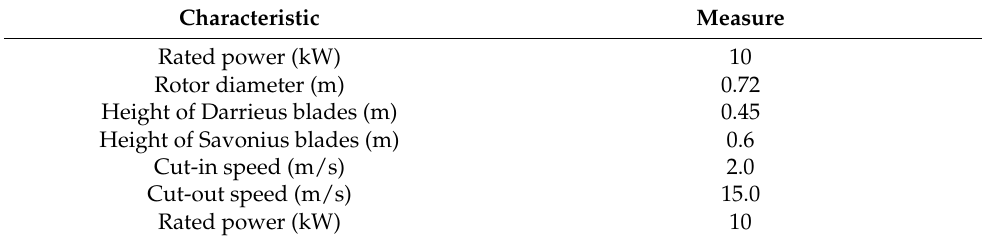
Table A1. Dimensions and operational characteristics of the wind tree.